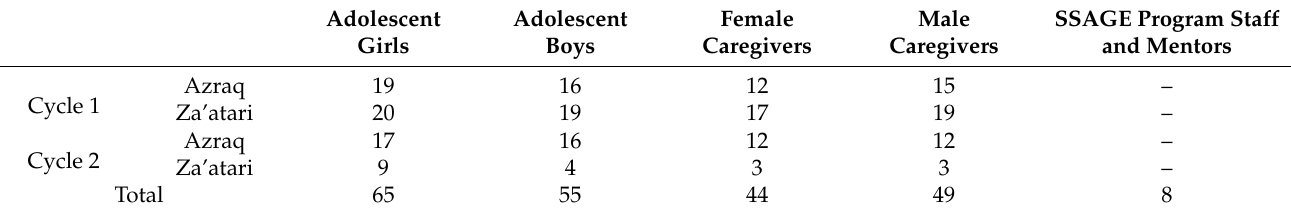
Table 1. Qualitative methods